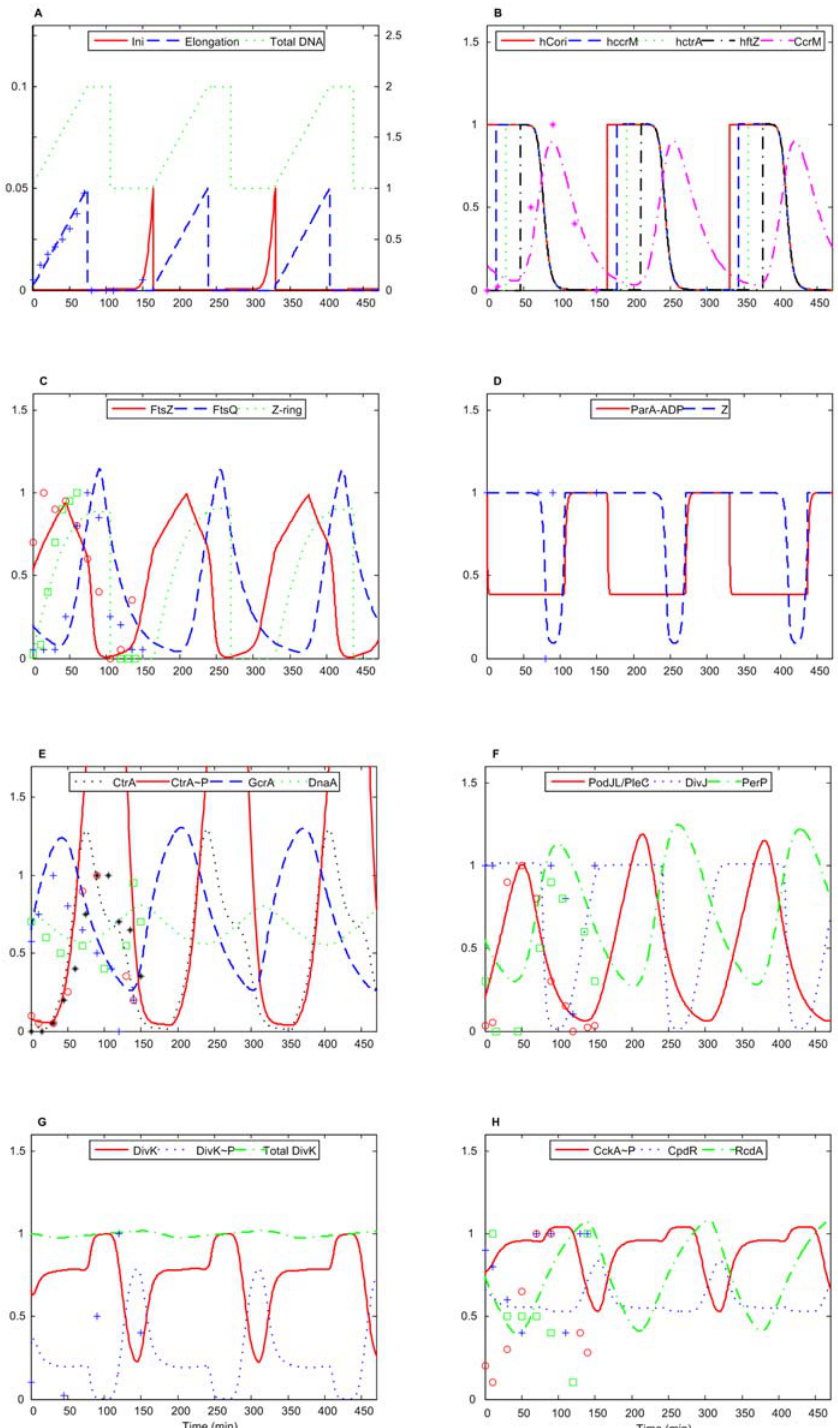
Figure 4. Simulated variations of proteins and other model state variables during the swarmer wild-type cell cycle. Simulation begins with initiation of DNA replication. Three cell cycles are shown. Experimental data presented on some panels by open circles and squares, crosses and asterisks are re-plotted from the following sources: (A) Total DNA from Figure 4 in [84]. (B) CcrM from Figure 2 in [85]. (C) FtsZ from Fig. 2C in [86]; Zring from Fig. 3C in [87]; FtsQ from figure 2 in [86]. (D) Z from Figure 2 in [88]. (E) CtrA from Fig. 3C in [40]; CtrA , P from Fig. 3C in [36]; GcrA from Figure 3 in [40]; DnaA from Figure 5 in [89]. (F) PodJL/PleC from Fig. 1A in [55] and Fig. 1B in [34]; DivJ from Fig. 2B in [33]; PerP from Fig. 4 in [55]. (G) DivK , P from Figure 2 in [85]. (H) CckA , P from Fig. 3B in [36]; CpdR from Fig. 5A in [35]; RcdA from Fig. 2C in [38].